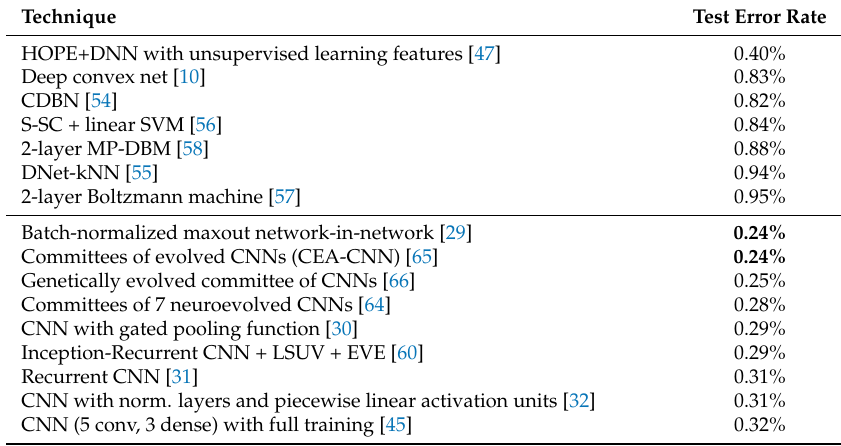
Table 2. Side-by-side comparison of the most competitive (error rate < 1%) results found in the state of the art for the MNIST database without data augmentation or preprocessing. Best achieved performances are